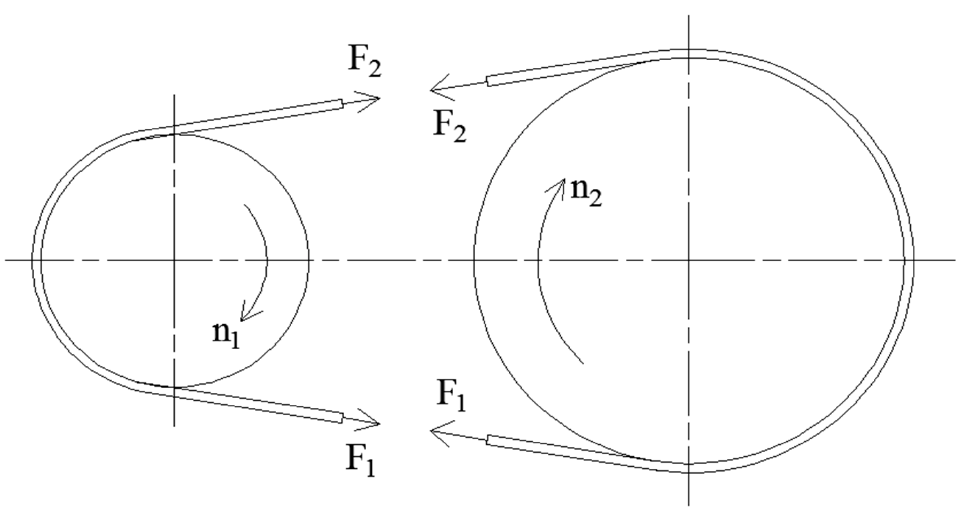
Figure 2. Stress diagram of a transport belt.